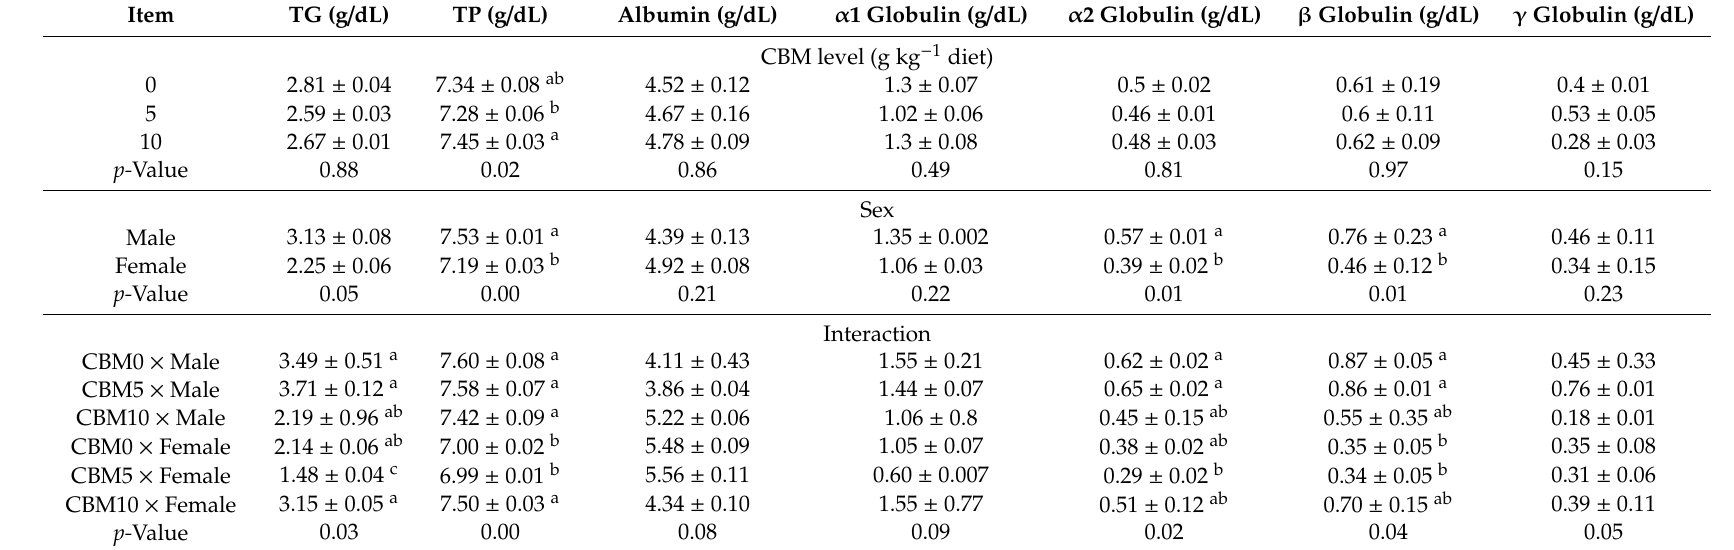
Table 4. E ff ect of dietary supplementation of cacao bean meal (CBM) on the blood biochemical parameters of broodstock C. auratus